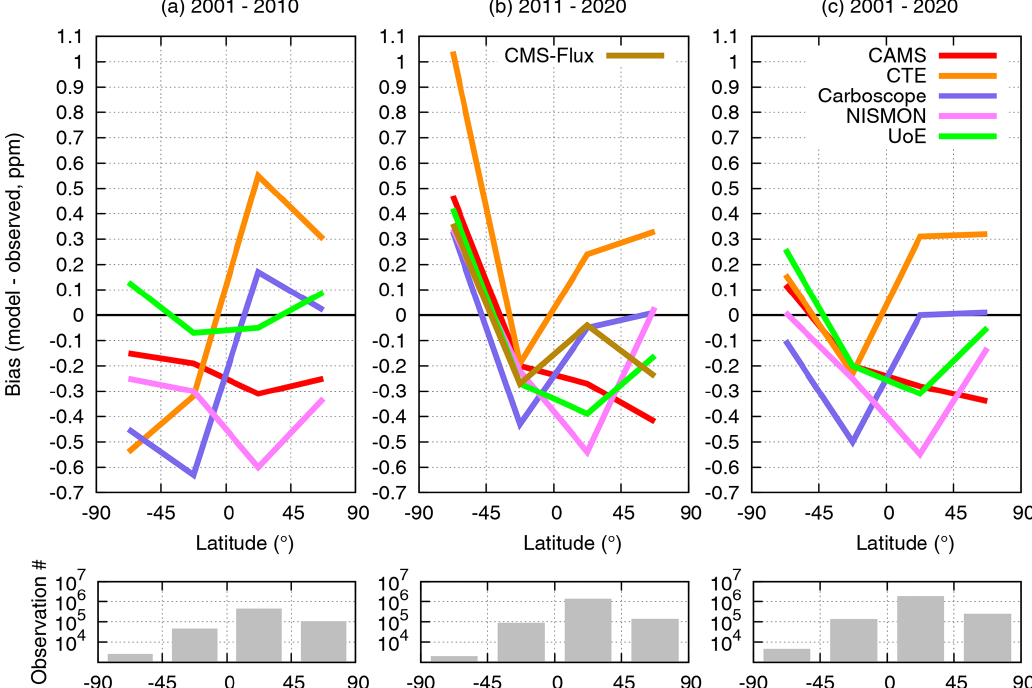
Figure B4. Evaluation of the atmospheric inversion products. The mean of the model minus observations is shown for four latitude bands in three periods: (a) 2001–2010, (b) 2011–2020, (c) 2001–2020. The six models are compared to independent CO 2 measurements made onboard aircraft over many places of the world between 2 and 7km above sea level. Aircraft measurements archived in the Cooperative Global Atmospheric Data Integration Project (CGADIP; Cox et al., 2021) from sites, campaigns, or programmes that cover at least 9 months between 2001 and 2020 and that have not been assimilated have been used to compute the biases of the differences in four 45 ◦ latitude bins. Land and ocean data are used without distinction, and observation density varies strongly with latitude and time as seen in the lower